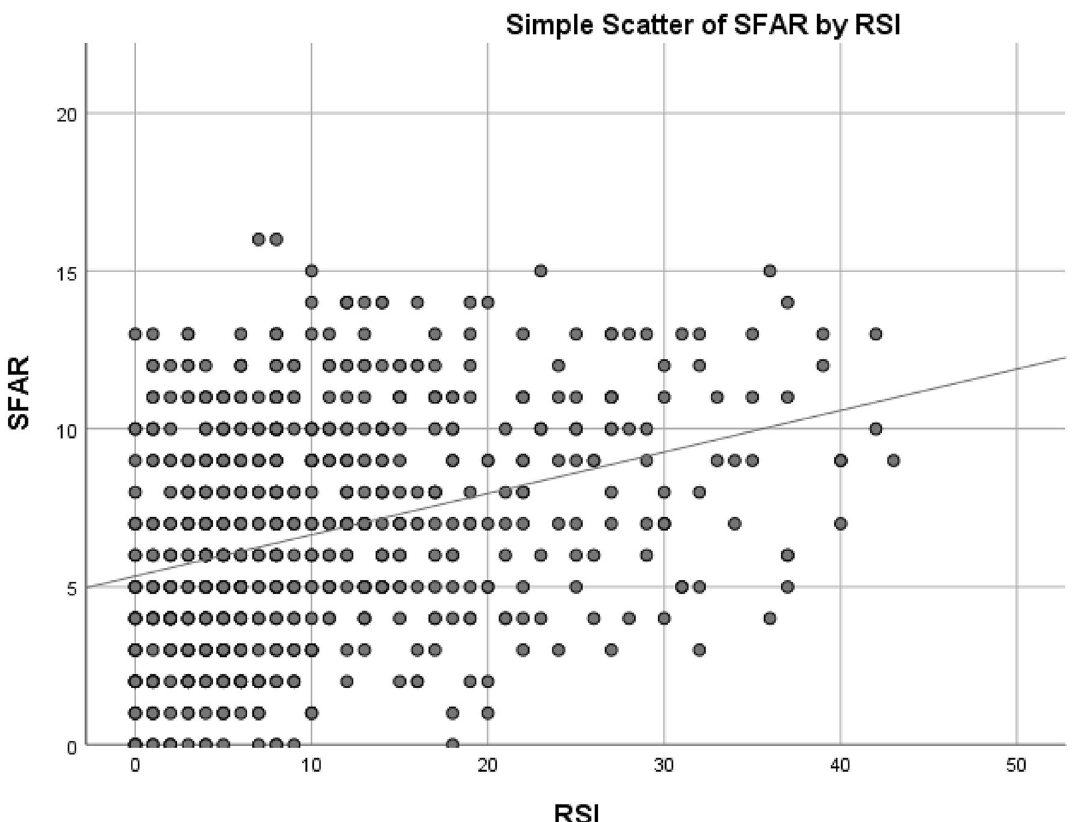
Figure 1. Showing the scatter of RSI and SFAR score values in all participants with r = 0.334 at p < 1 × 10 –19 .